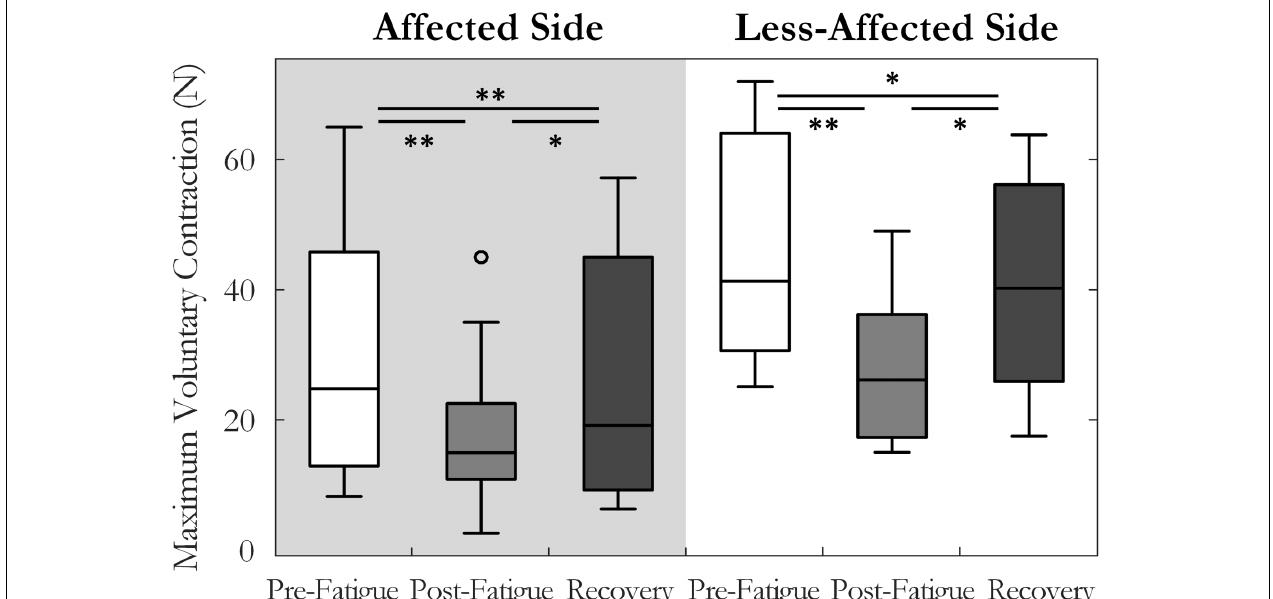
FIGURE 2 | Median and interquartile range of the maximum voluntary contraction force across all subjects tested pre-fatigue, post-fatigue, and after the recovery period, on the affected and less-affected sides ( ∗ p < 0.05, ∗∗ p < 0.01).